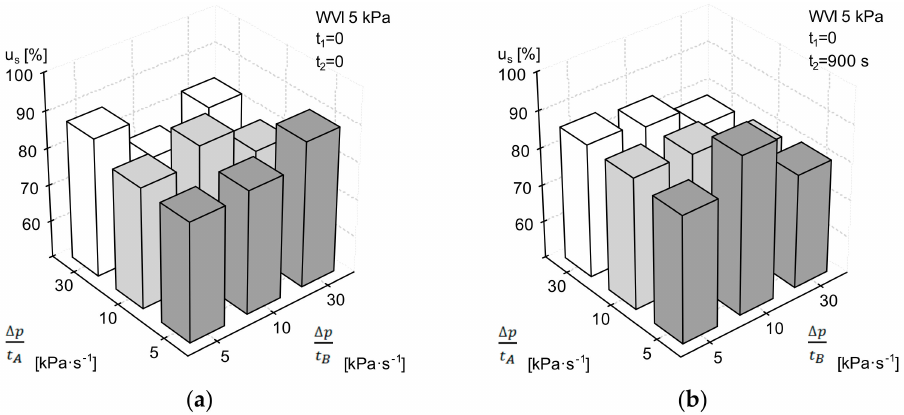
Figure 5. Dependence of the percentage of apple tissue staining u S on the pressure change rate in the